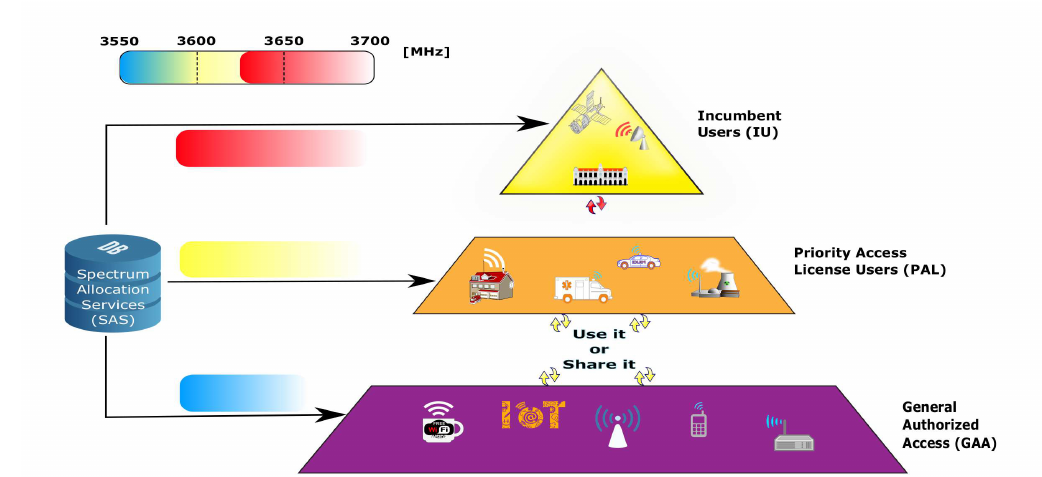
Figure 1. Three-tier hierarchical architecture of the